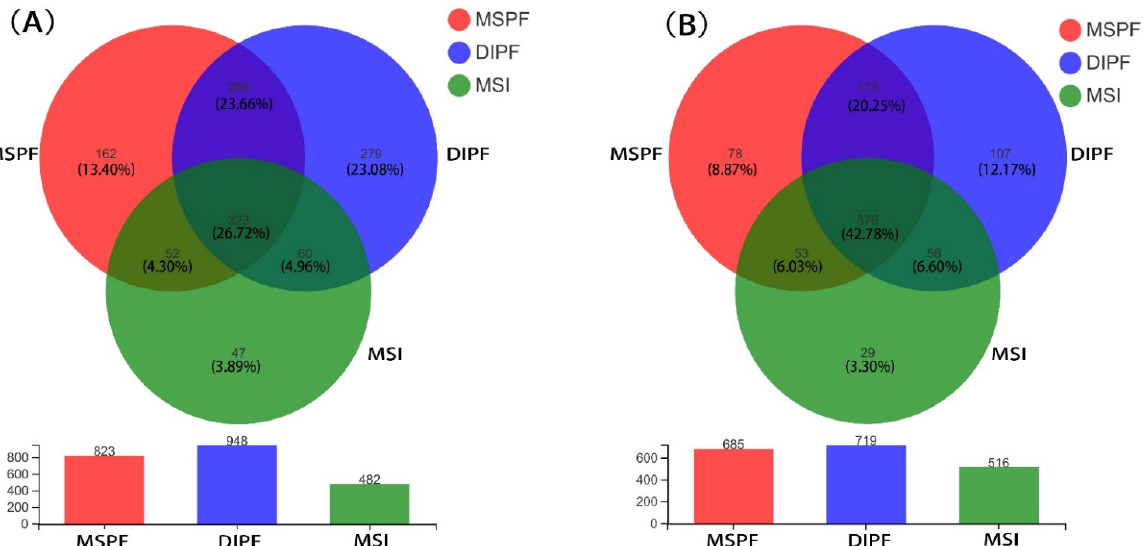
Figure 7. Venn diagram showing the unique and shared nirS -type denitrifying bacteria in rhizosphere soil samples at the OTU classification level under different irrigation strategies and PF during spring ( A ) and autumn ( B ).